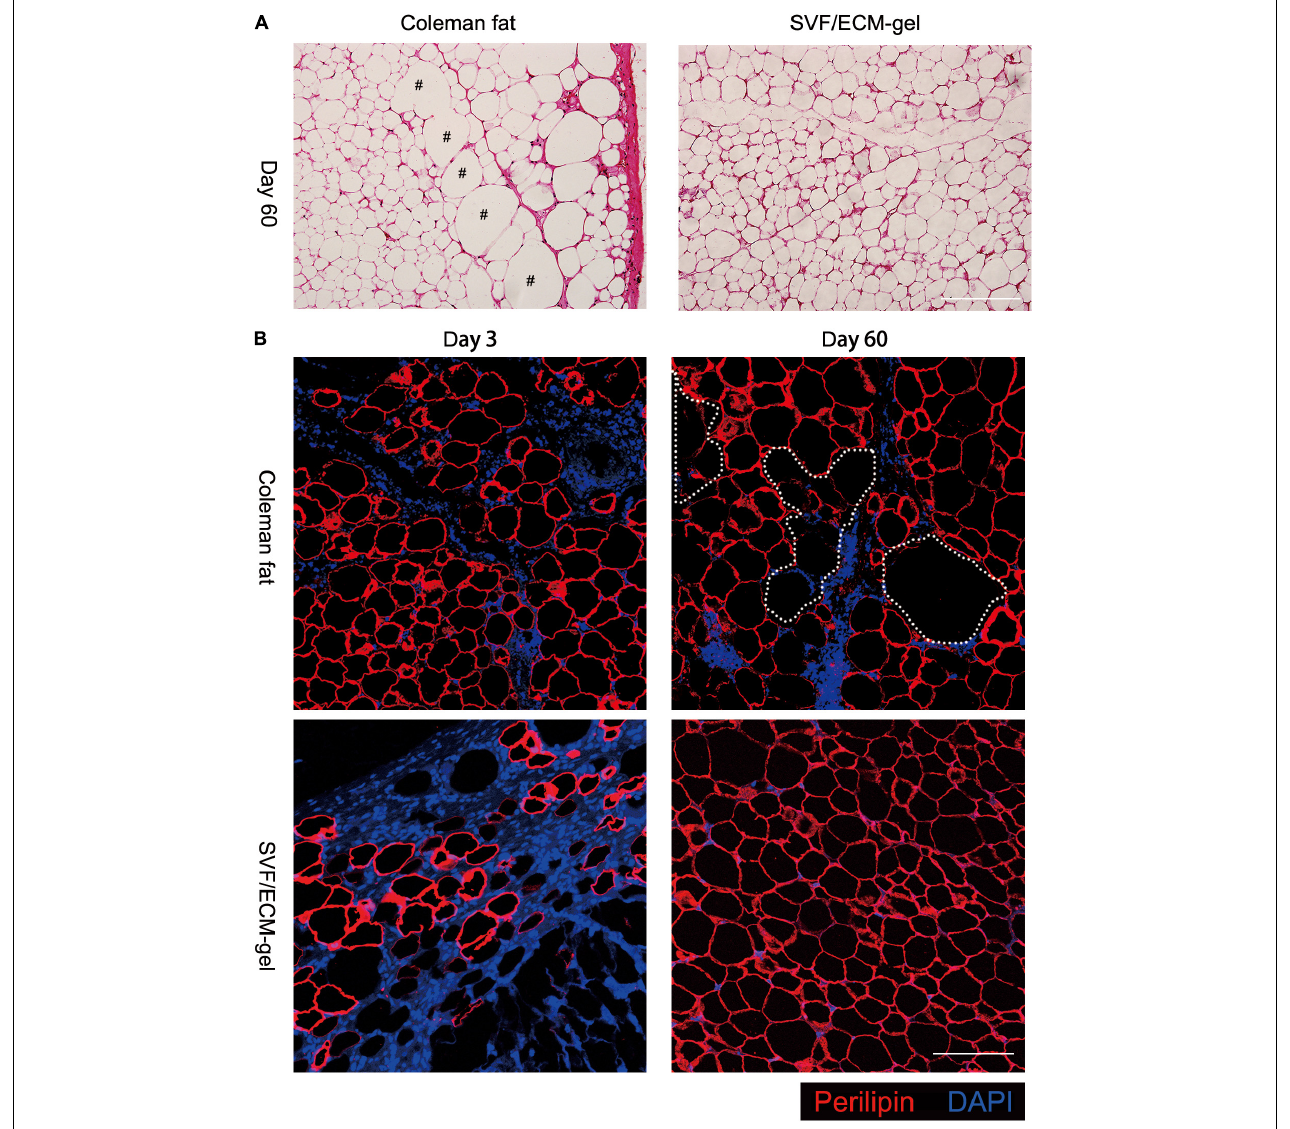
FIGURE 3 | Histological changes in the transplanted fat. (A) Hematoxylin and eosin staining on day 60 after transplantation showing that the SVF/ECM gel formed a mature lobular fat structure (right), whereas some oil droplets remained in the Coleman fat grafts (left); scale bars = 200 µ m. (B) Fluorescence staining showing that 3 days after transplantation, the adipocytes in the SVF/ECM gel grafts were necrotic, and the negative area of perilipin was significantly increased (lower left), compared to the Coleman fat grafts (upper left); 60 days after transplantation, a large number of new adipocytes with positive perilipin staining were found in the SVF/ECM gel grafts (lower right), with many negative areas (upper right) of perilipin in the Coleman fat grafts; scale bars = 100 µ